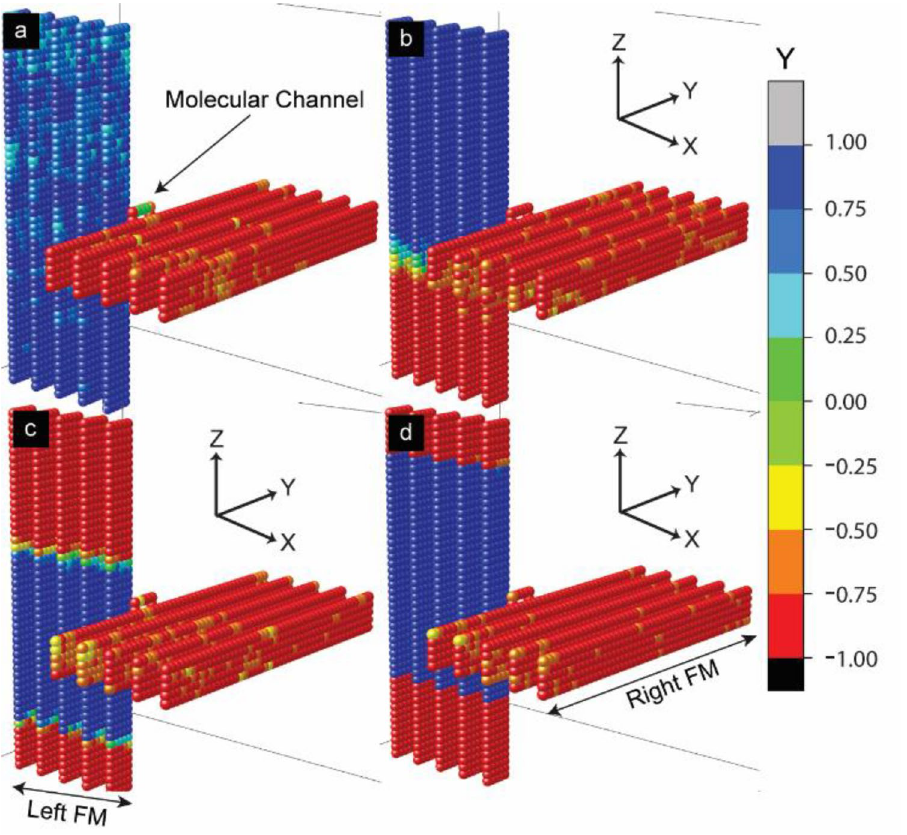
Figure 3. Simulated 3D lattice model of the MTJMSD measured at kT = 0.1. ( a ) For A LY = 0 direcrtion of stablization can be anywhere in 3D space. For ( b ) A LY = 0.1, ( c ) A ALY = 0.4, and ( d ) A LY = 1 electrode spins predominently align parallel or antiparallel to the easy Y axis. For ( a ) color bar represent magnetic moment along the direction of stablization that is not necessarily easy axis. For ( b–d ) color bar represent magnitude of magnetic moment parallel or antiparallel with respect to Y